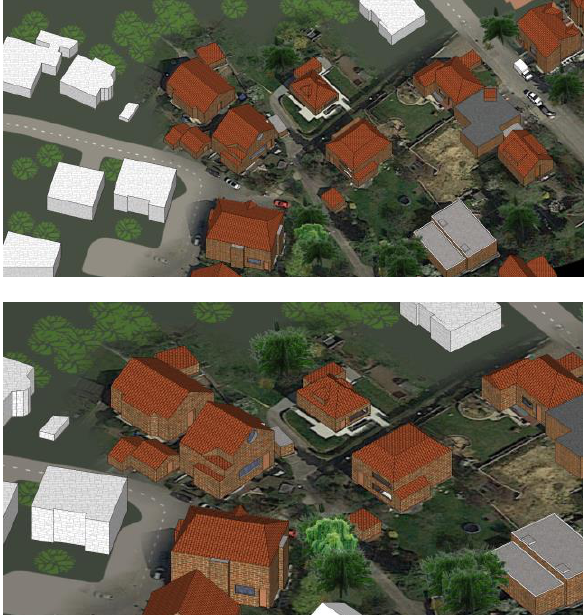
Figure 6. Residential urban scene featuring two different levels of detail for different portions of the privacy enabled 3D map (image ©